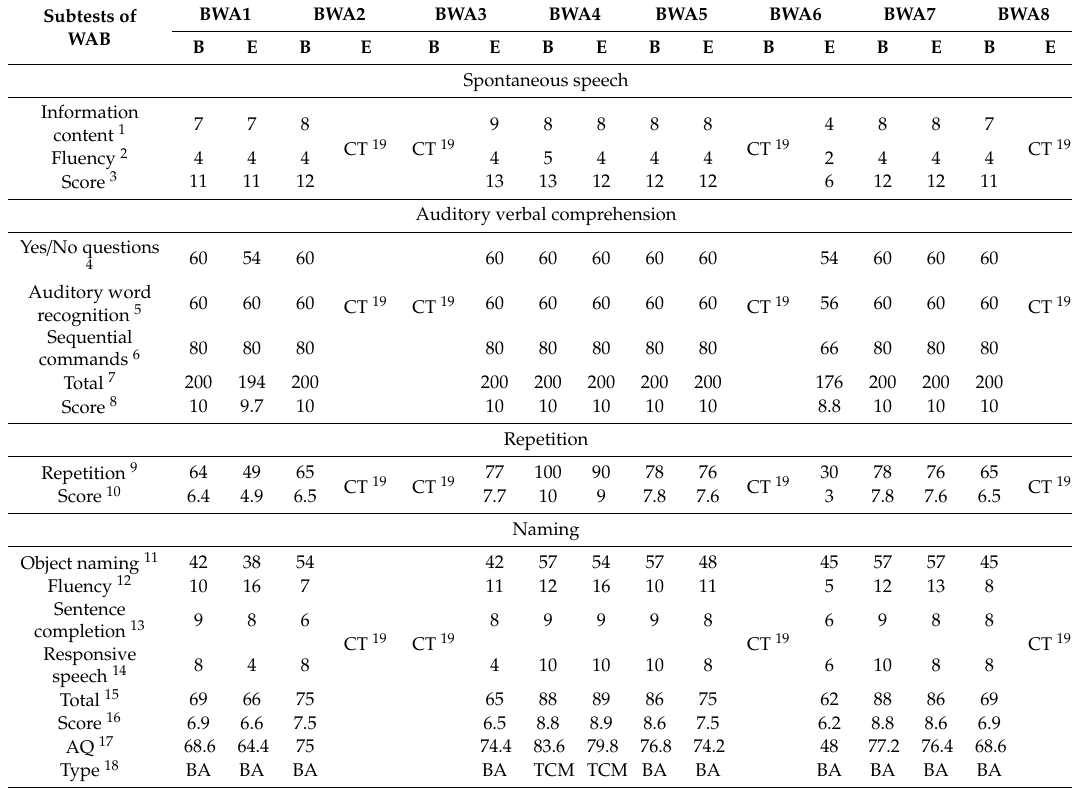
Table A1. Western aphasia battery test scores in Bengali (Keshri et al., 2013) and English (Kertesz, 2006) of each